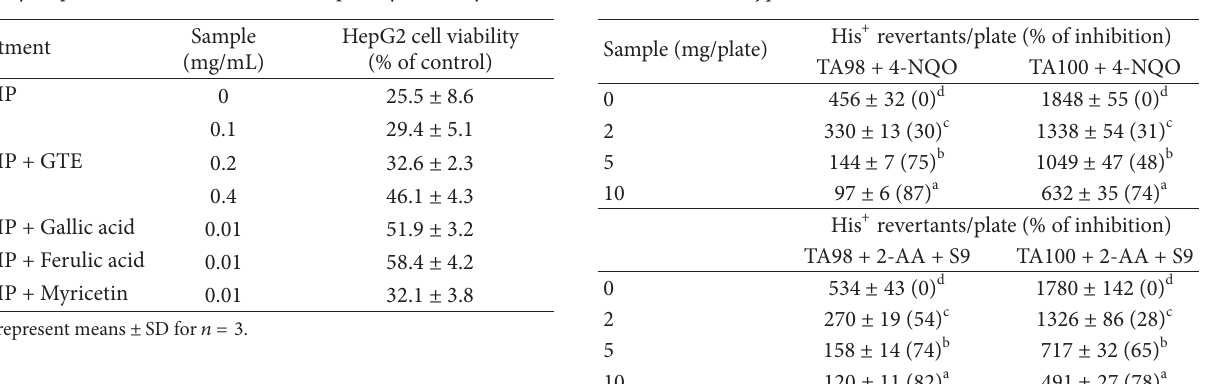
T 5: e mutagenicity of the aqueous extract of guava twigs (GTE) toward S. typhimurium TA98 and TA100 with and without S9 mix.